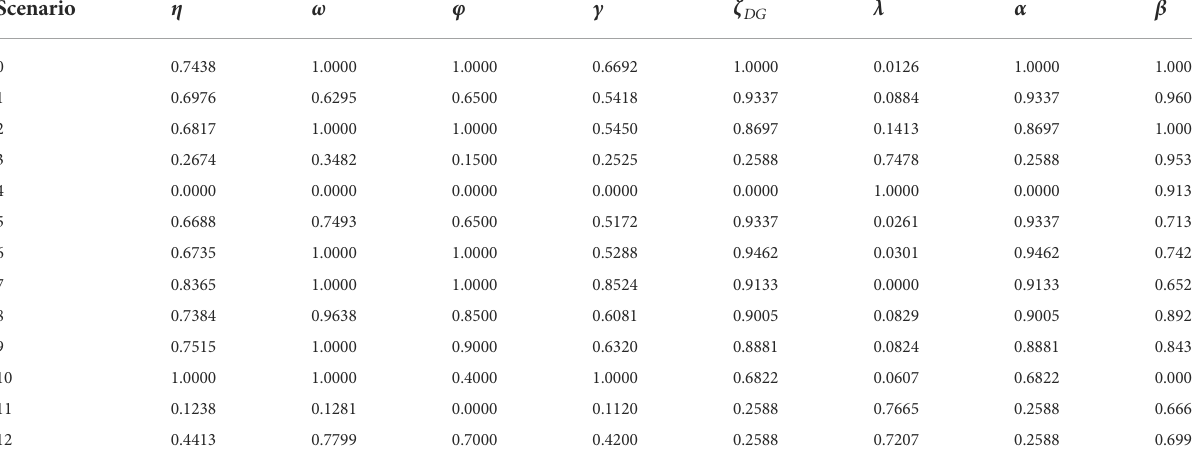
TABLE 6 Standardized situation assessment indexes of the ADN under different cyberattack scenarios. Scenario